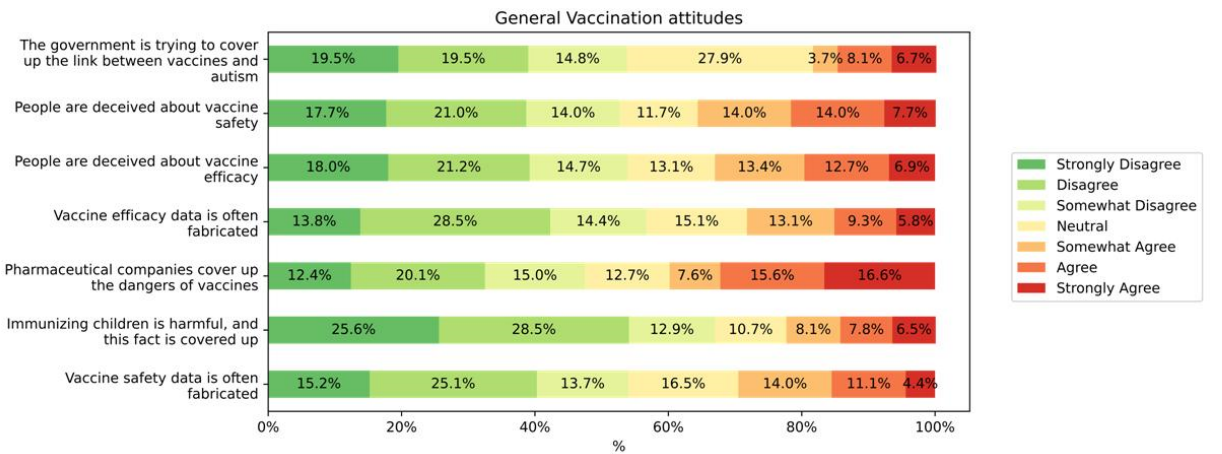
Figure 4. The distribution of vaccination attitudes among the participants.